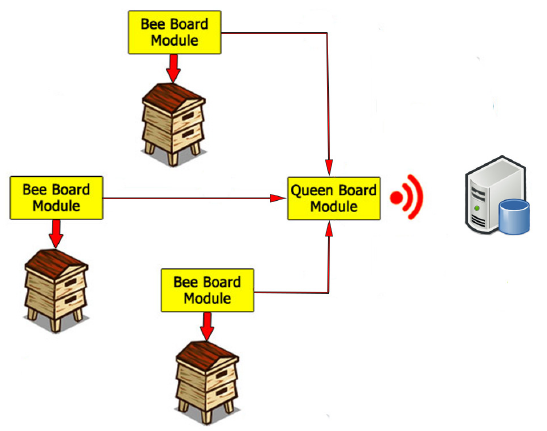
Figure 1. Connection between the Bee board and the Queen board modules with the remote